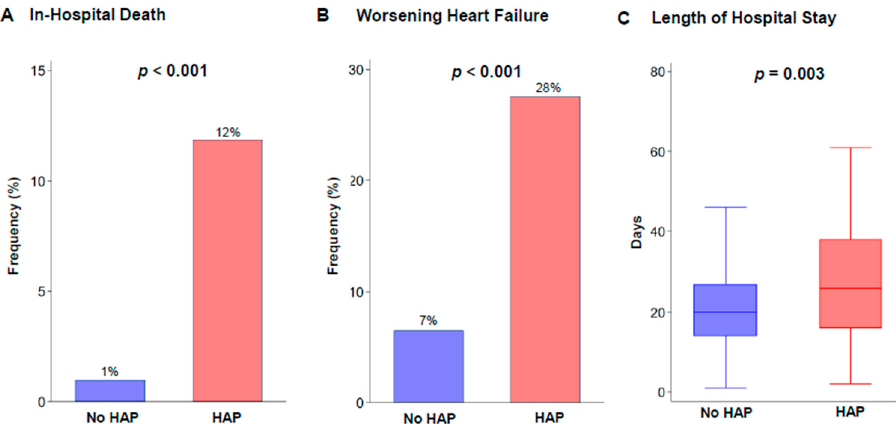
Figure 2. Incidence of adverse events during hospitalization. ( A ) In-hospital death, ( B ) Worsening heart failure, ( C ) Length of hospital stay. HAP, hospital-acquired pneumonia. Table 2. Determinants of worsening heart failure during hospitalization. Univariable Analysis Multivariable Variable